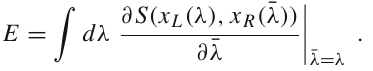
been discussed in the text and portrayed in Fig. 2. The second curve illustrates the fact that N can be odd, because x (cid:10) does not necessarily flip sign in going from one segment to the next (in this example, and with the conventions described in the main text, segments n = 3 , 4 are both positive). The third example illustrates the fact that the curve can